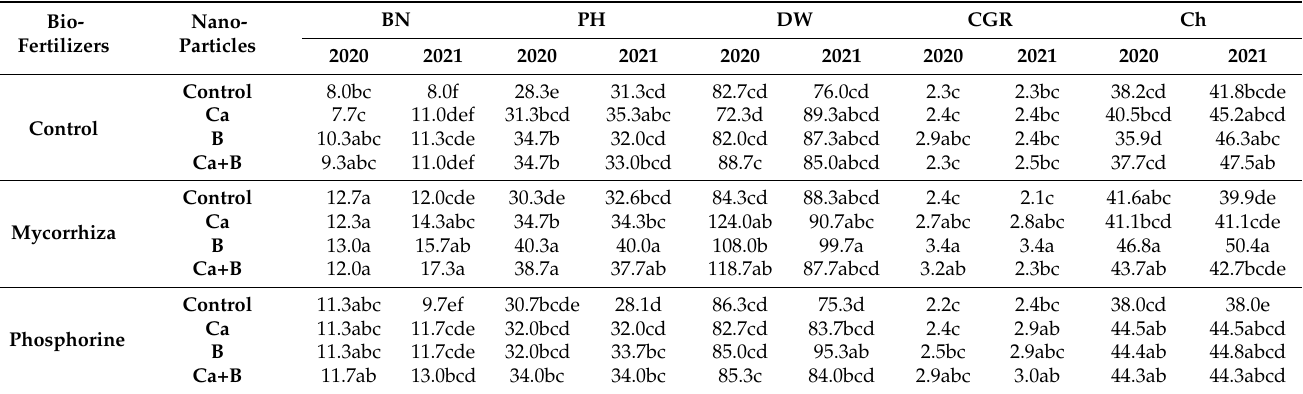
Table 3. Effects of interaction between biofertilizer and nanoparticle treatments on peanut growth parameters across two successive seasons (2020 and 2021).